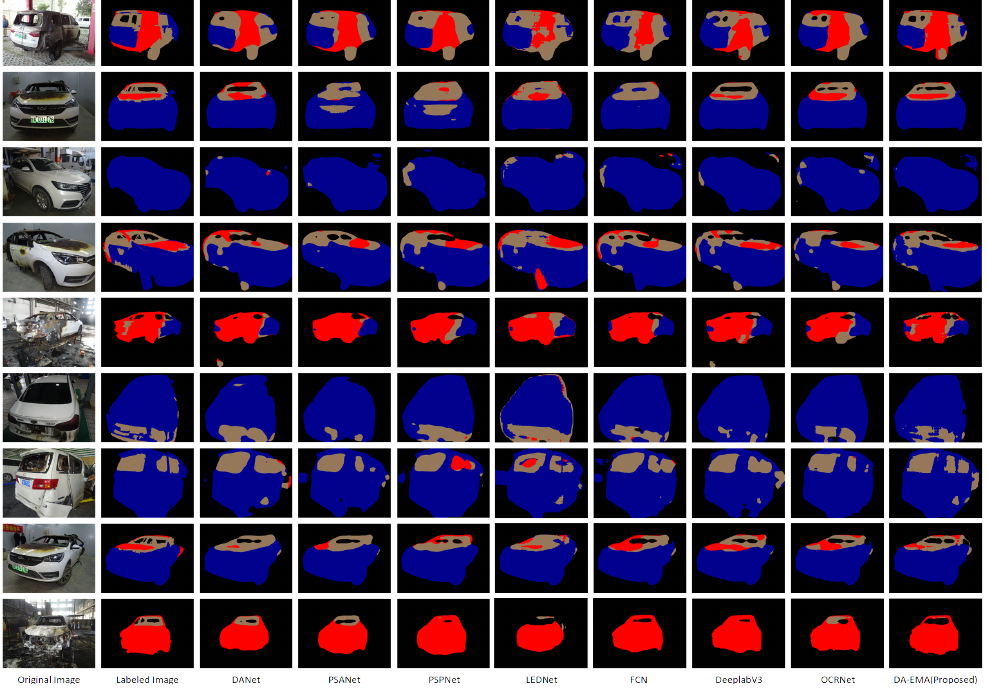
Figure 8. Results of the proposed DA-EMA and other semantic segmentation